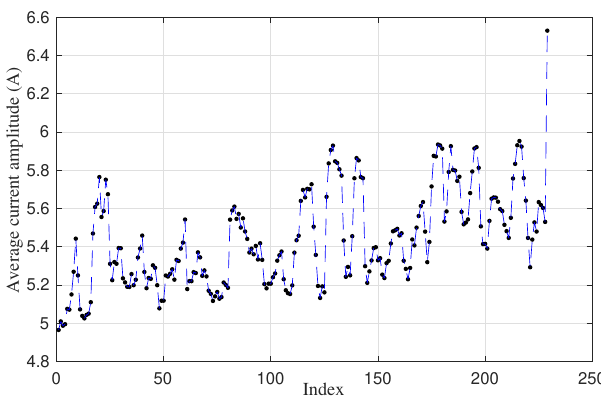
Figure 3. An example of degradation path.